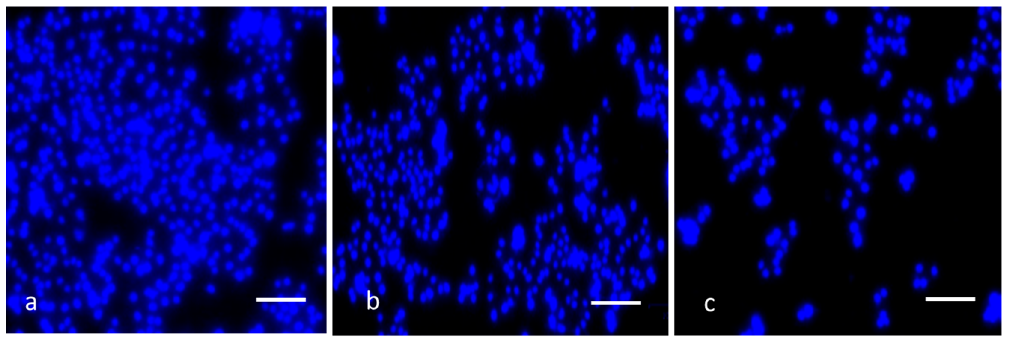
Figure 9. MDA-MB-231 cells with MgO-Chitosan-Pluronic F127-Escin NPs have altered nuclear integrity. MgO-Chitosan-Pluronic F127-Escin NPs were used to treat breast cancer MDA-MB-231 cell lines. DAPI was used to stain the cells, and a representative stained cell was shown for each group. Control ( a ), 10 µ g/mL of MgO-Chitosan-Pluronic F127-Escin NPs-treated cells ( b ), and 20 µ g/mL of MgO-Chitosan-Pluronic F127-Escin NPs-treated cells ( c ). 20 × magnification was used to capture the images (scale bar 50 µ